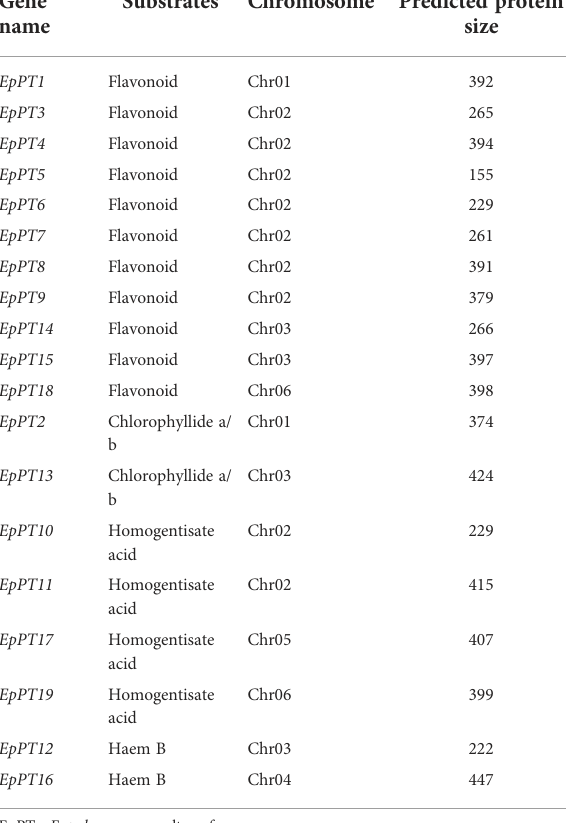
TABLE 2 Characteristics of 19 EpPT s.